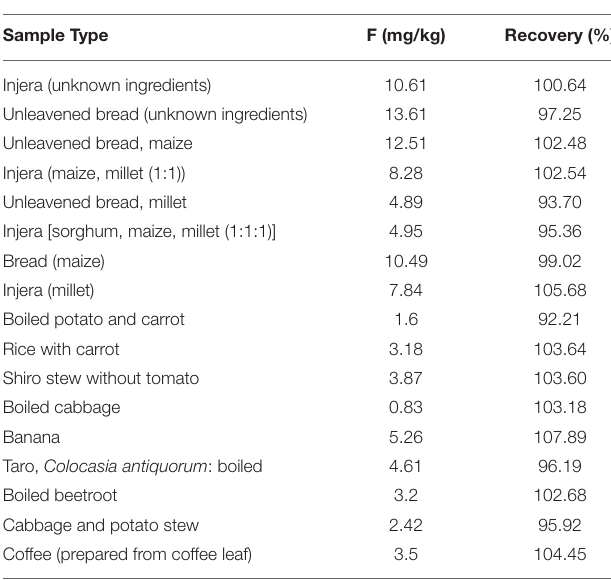
TABLE 3 | Fluoride levels of foods and beverages collected from Halaba zone SNNPR Ethiopia,